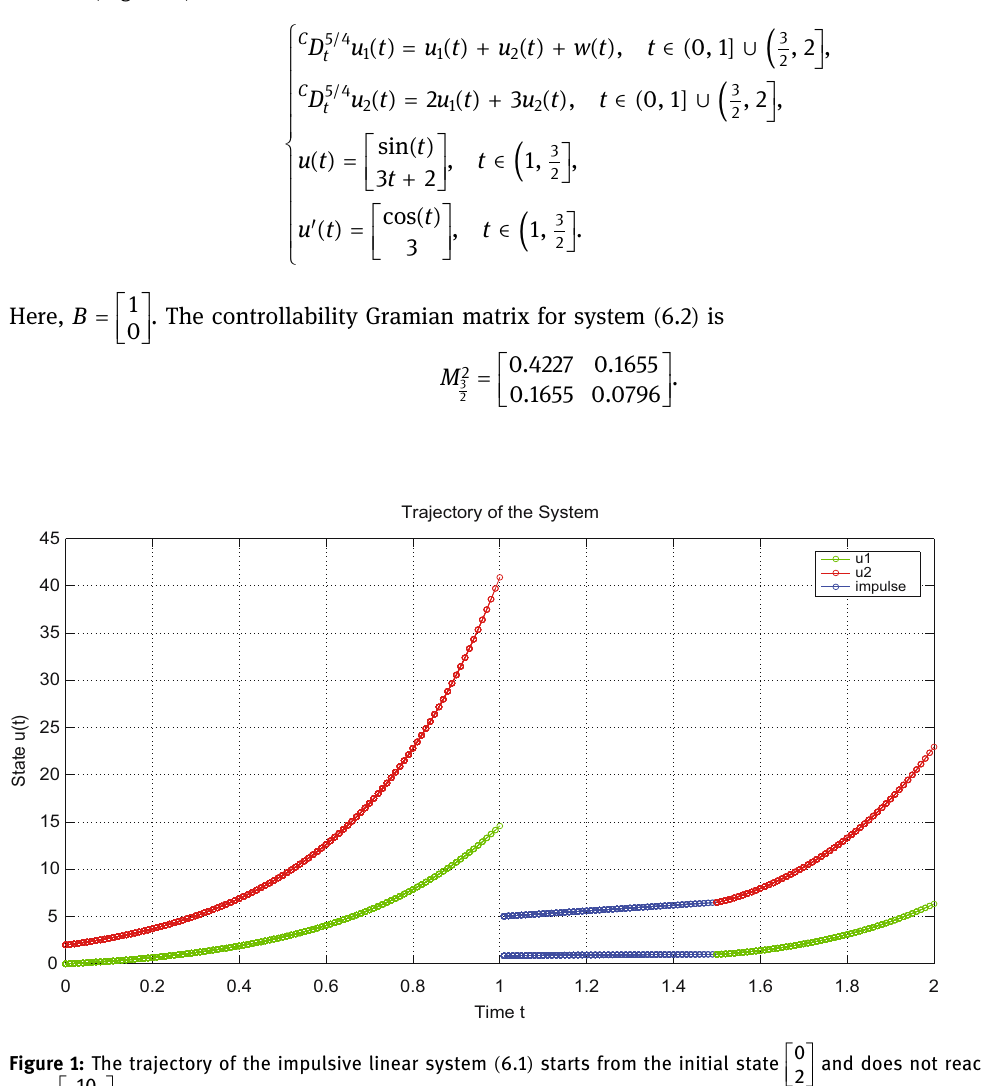
Figure 1: The trajectory of the impulsive linear system ( 6.1 ) starts from the initial state 10   on 0, 2 [ ] state  − 10  